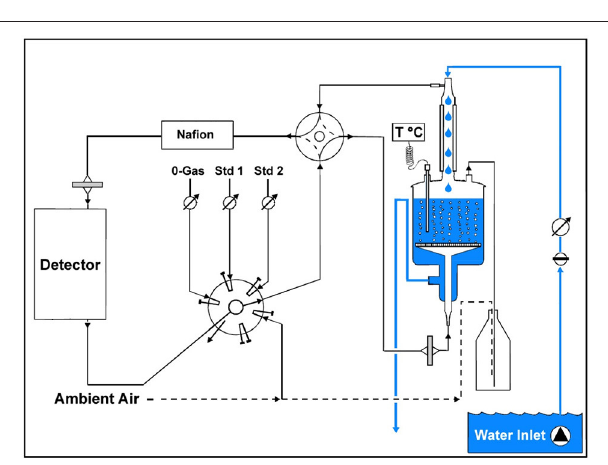
FIGURE 2 | Scheme of the N 2 O measurement